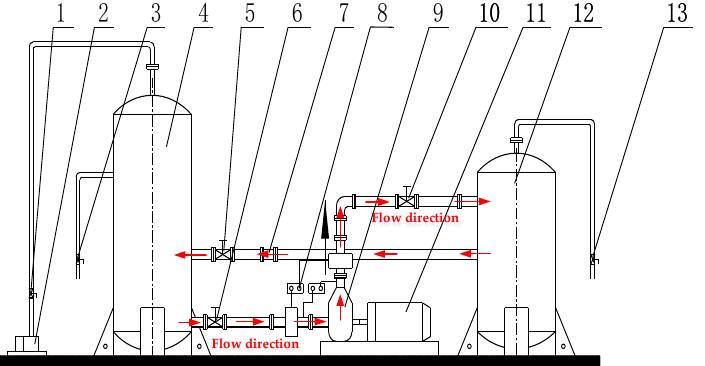
Figure 3. Schematic of the experimental test rig. (1, 3, 13) Ball valve; (2) vacuum pump; (4) pressure tank; (5, 10) butterfly valve; (6) gate valve; (7) turbine flowmeter; (8) pressure transmitter; (9) test pump; (11) electromotor; (12) buffer tank.